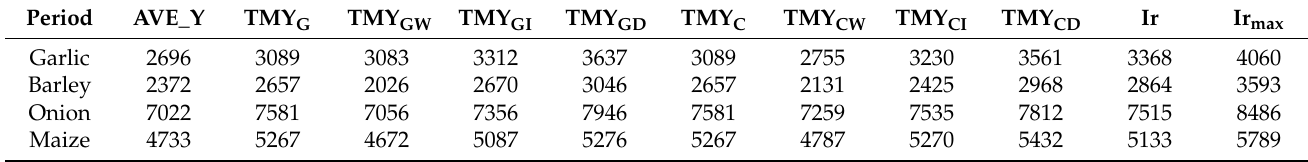
Table 4. Net irrigation requirements (m 3 ha − 1 ).